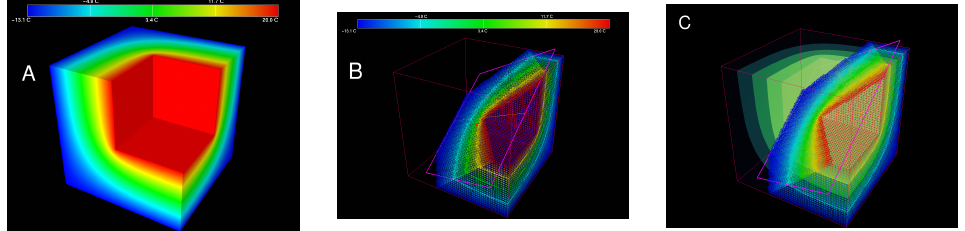
Figure 2. ( A ) A three-dimensional solution on an interior corner. ( B ) A section of the solution containing the point ( 0.25,0.25,0.25 ) , marked with a red cross. ( C ) A generic